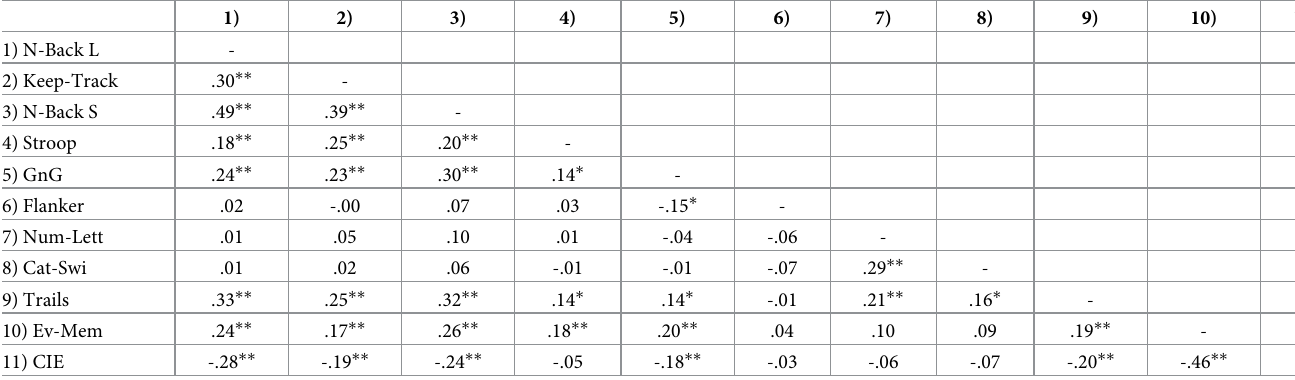
Table 2. Correlations between the Nine EF tasks and CIE task (N =